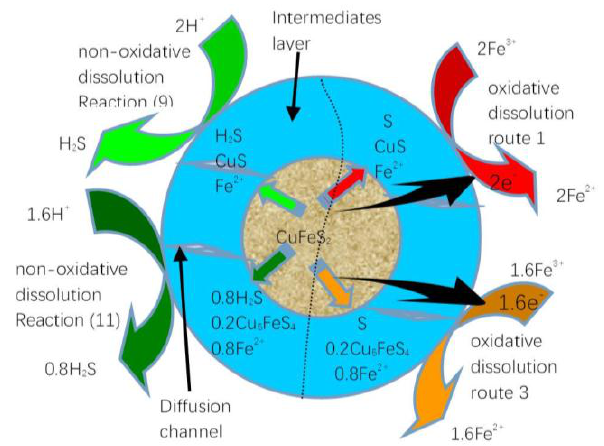
Figure 4. Possible chalcopyrite dissolution reaction routes.